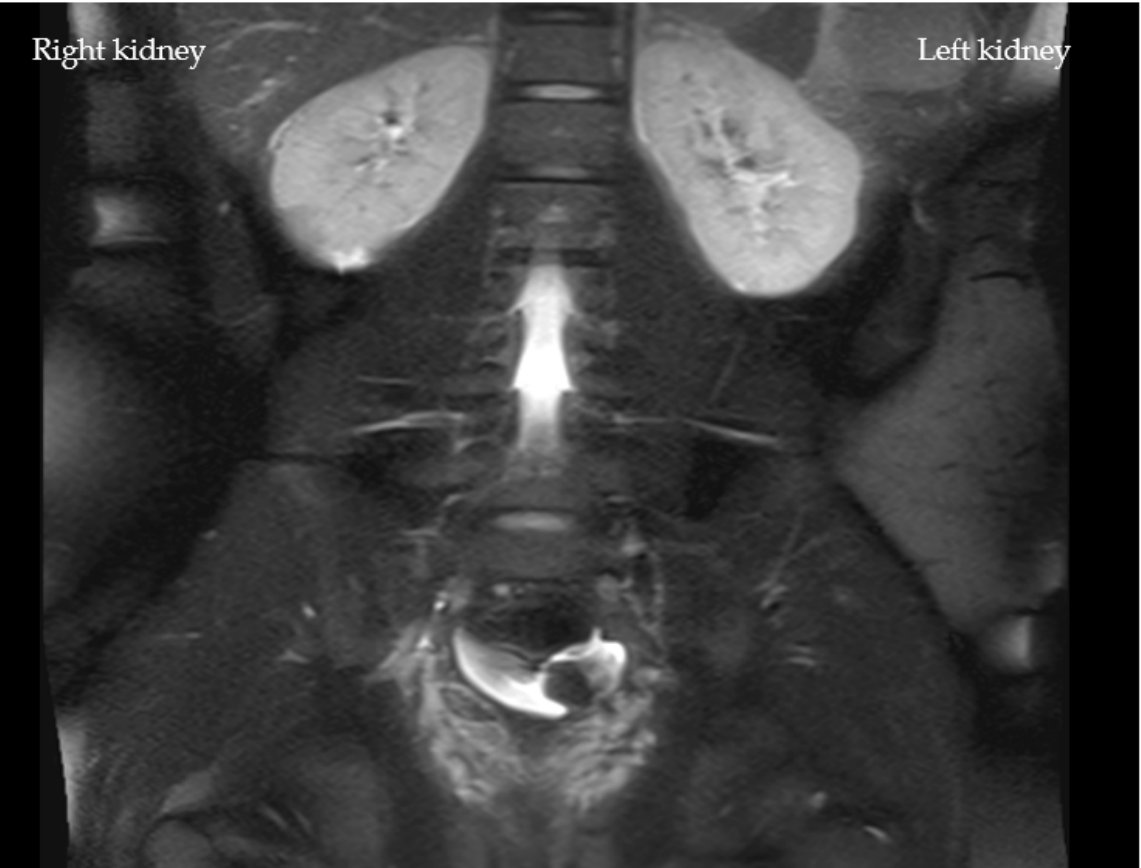
Figure 2 . MRI of the abdomen of Case I° with a frontal cut of the two kidneys. An MRI of the abdomen showed a mildly enlarged appendix without surrounding edema and little free fluid in the pelvis. The kidneys showed mildly irregular signaling in the upper renal pole on both sides and the lower pole on the right side (cortical). Duplex sonography of the renal artery showed a laterally symmetrical resistance index normal for age.